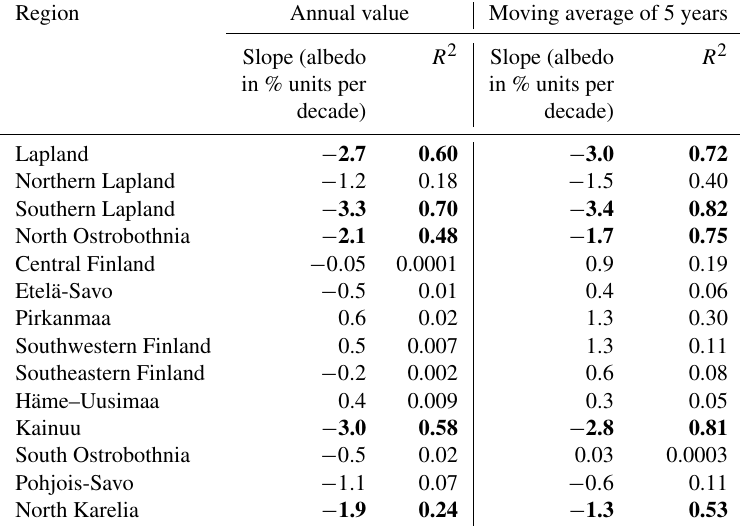
Table 5. The observed albedo trends of the regions based on the forest centres. Values for the slope and the coefficient of determination are shown both for annual data and moving averages of 5 years. The region Lapland is divided into northern and southern parts as shown in Fig. 1. The cases for which the moving average of 5 years shows a significant coefficient of determination are indicated with bold fonts. Region Annual value Slope (albedo R 2 Slope